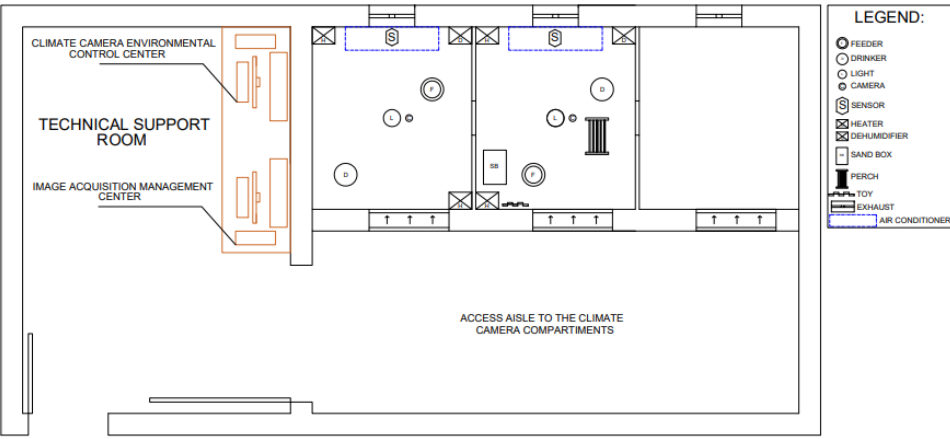
Figure 1. Plan view of the environmental chamber (adapted from [47]). Reprinted/adapted with permission from Ref. [47]. 2022, Daniella Jorge de Moura.